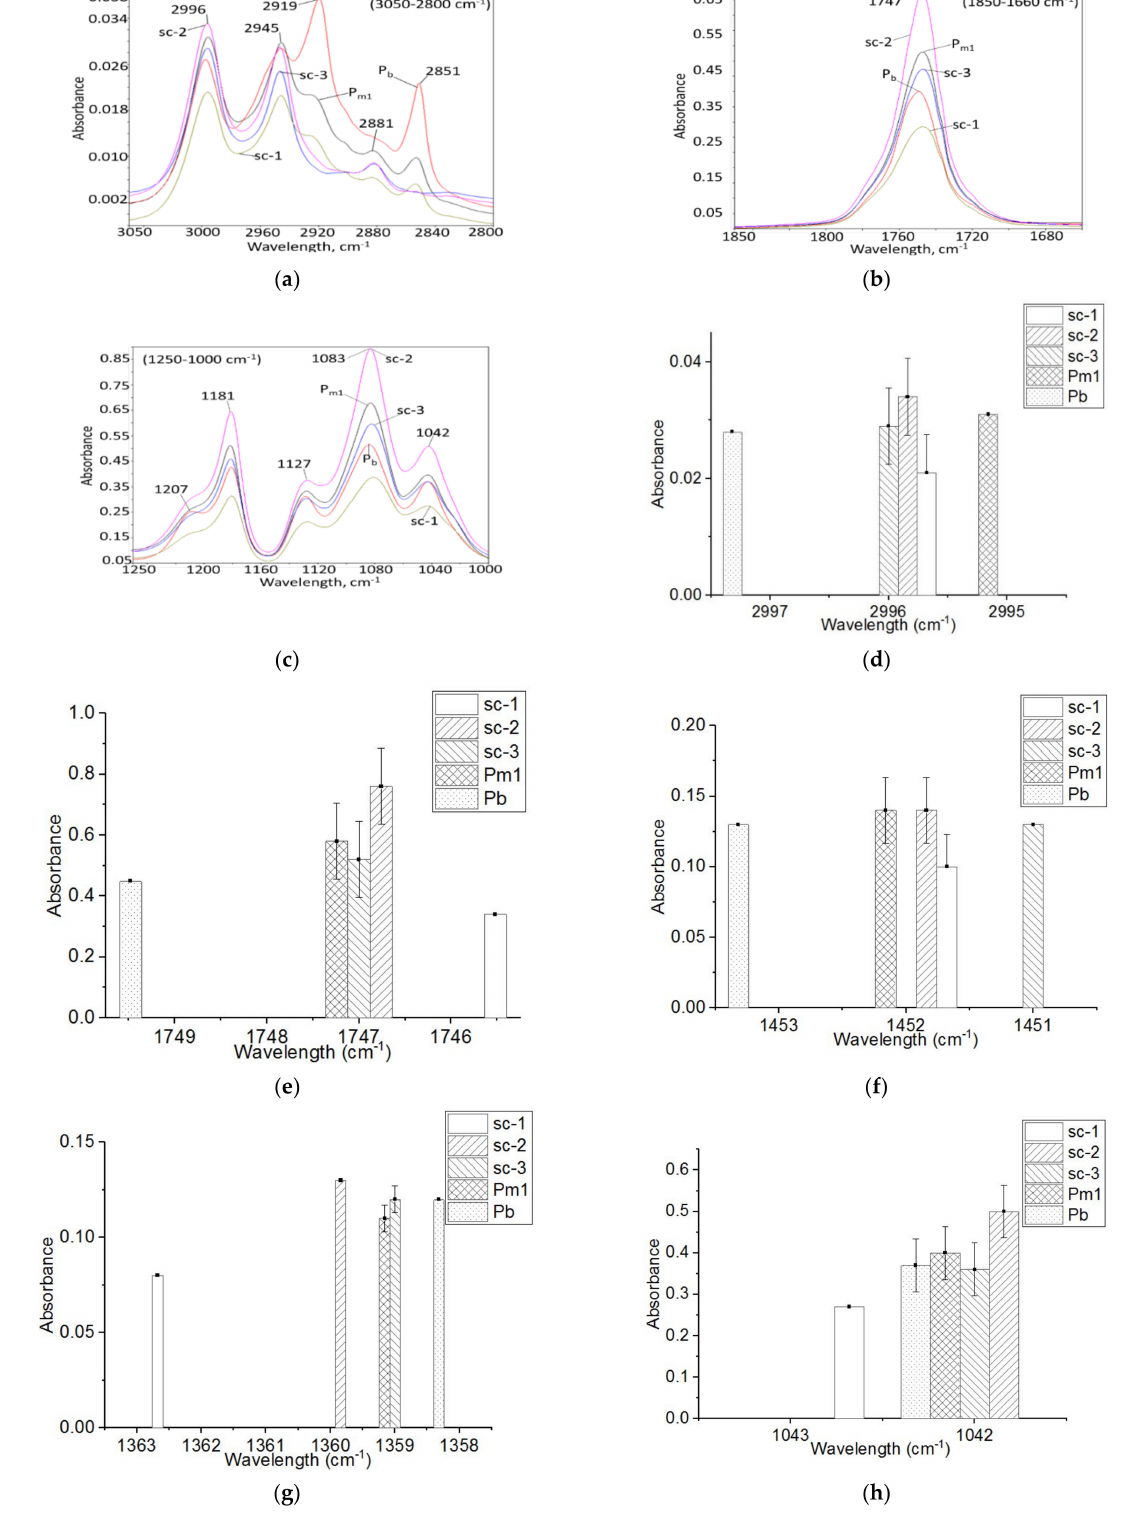
Figure 2. FTIR spectra of the sc-1, sc-2 and sc-3 compounds and those of the used PLA (base-PLLA and PDLA for stereo- complexing with medium M w and medium D-lactide content). ( a ) 3050–2800 cm − 1 range; ( b ) 1850 –1680 cm − 1 range; ( c